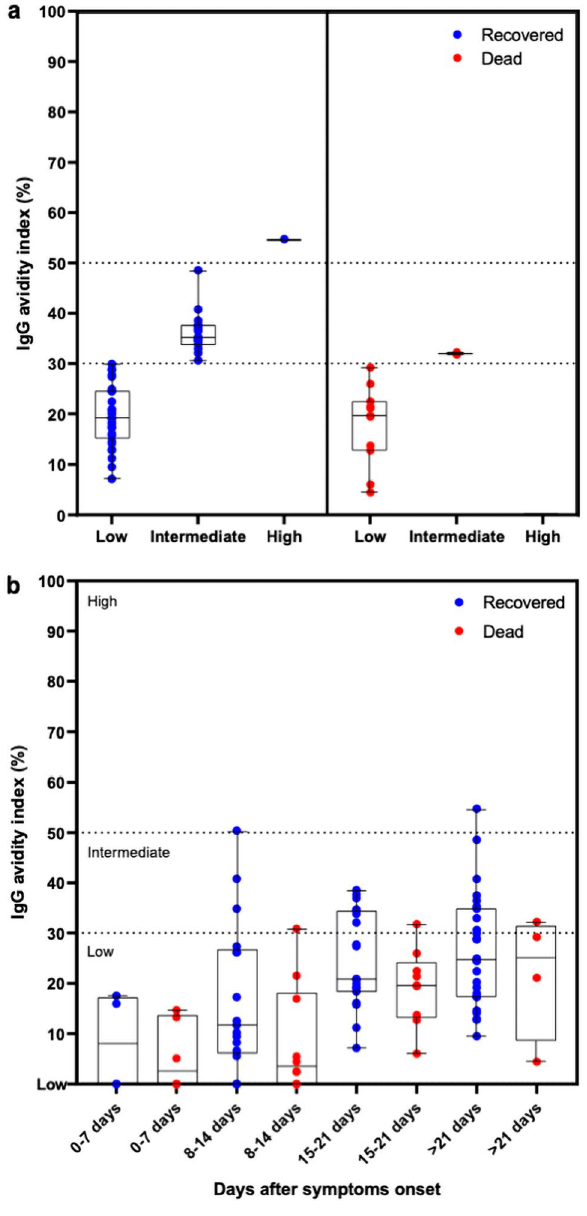
Figure 3. Binding strength of IgG antibody to SARS-CoV-2 RBD (avidity) in COVID-19 patients. ( a ) IgG antibody avidity in patients who recovered (blue) or who died (red) with COVID-19. The IgG antibody avidity was expressed as the Avidity Index (AI %). The dash lines indicate the avidity range (low, intermediate, and high). ( b ) IgG antibody avidity to RBD concerning the time after symptom onset in recovered or dead groups. Aligned dot plots and boxplots show AI values (dots), medians (middle line), third and first quartiles (boxes), while the whiskers display the minimum and maximum values. Statistically significant differences were analyzed by Kruskal–Wallis and Dunn’s multiple comparisons test or Mann–Whitney test when appropriate ( P <